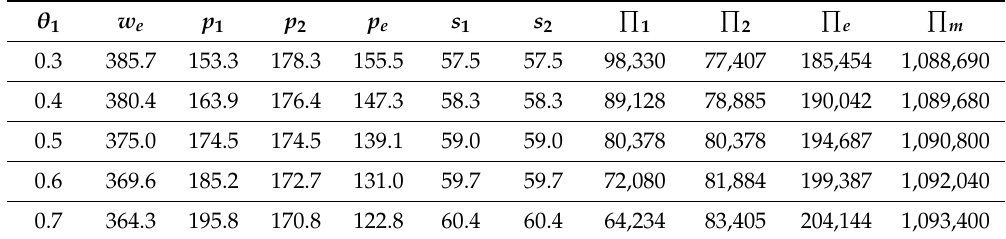
Table 2. The e ff ect of θ 1 on decisions by applying strategy S1.